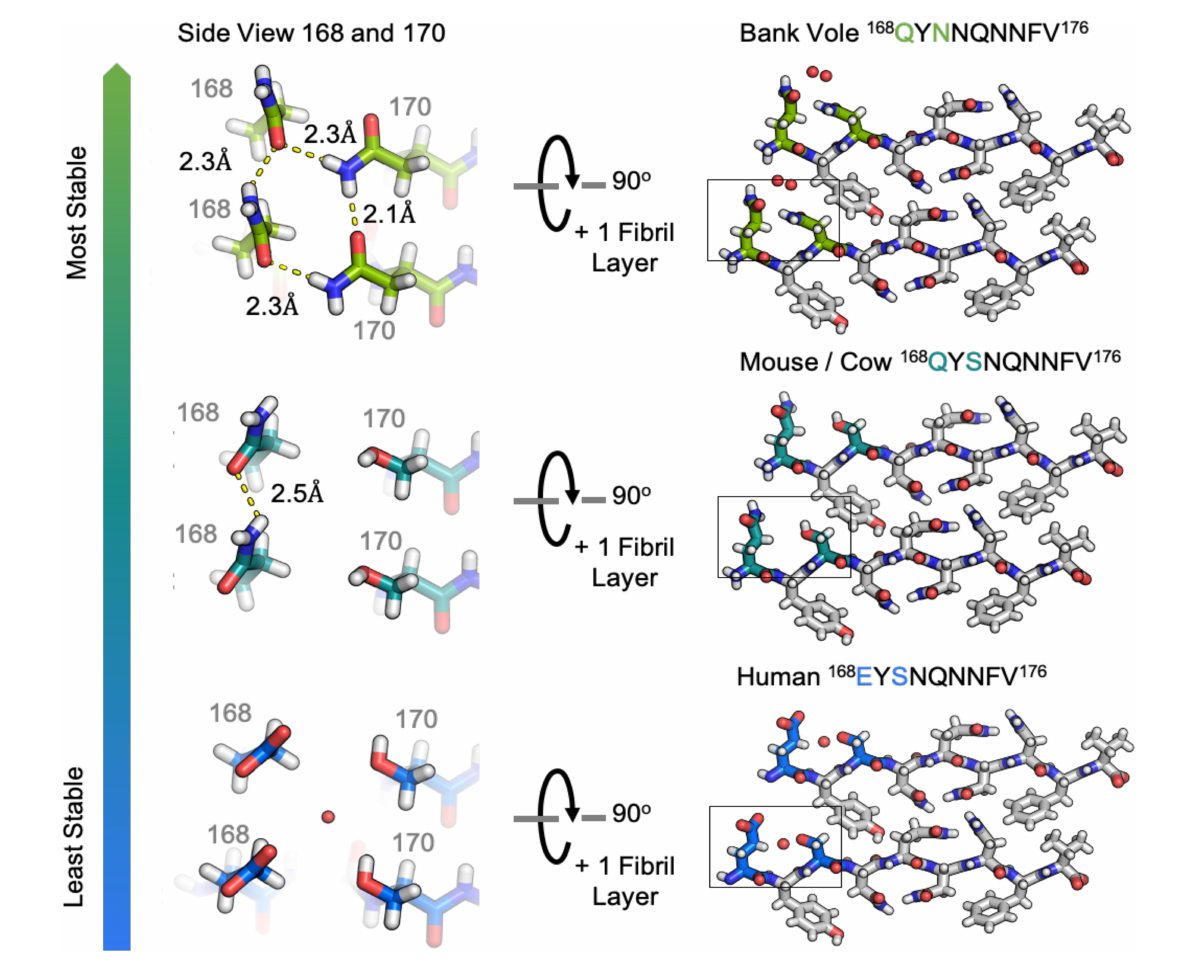
FIGURE4 Hydrogen bonding in clasped structures of segments from the β 2 α 2 Loop. Structures from the amyloid state of bank vole (top) mouse (center) and human (bottom) β 2 α 2 loops show a conserved interface and sets of hydrogen bond networks (right) . Species-specific differences in the hydrogen bonding networks between residues 168 and 170 give rise to differing stabilities for the three crystalline aggregates (left)